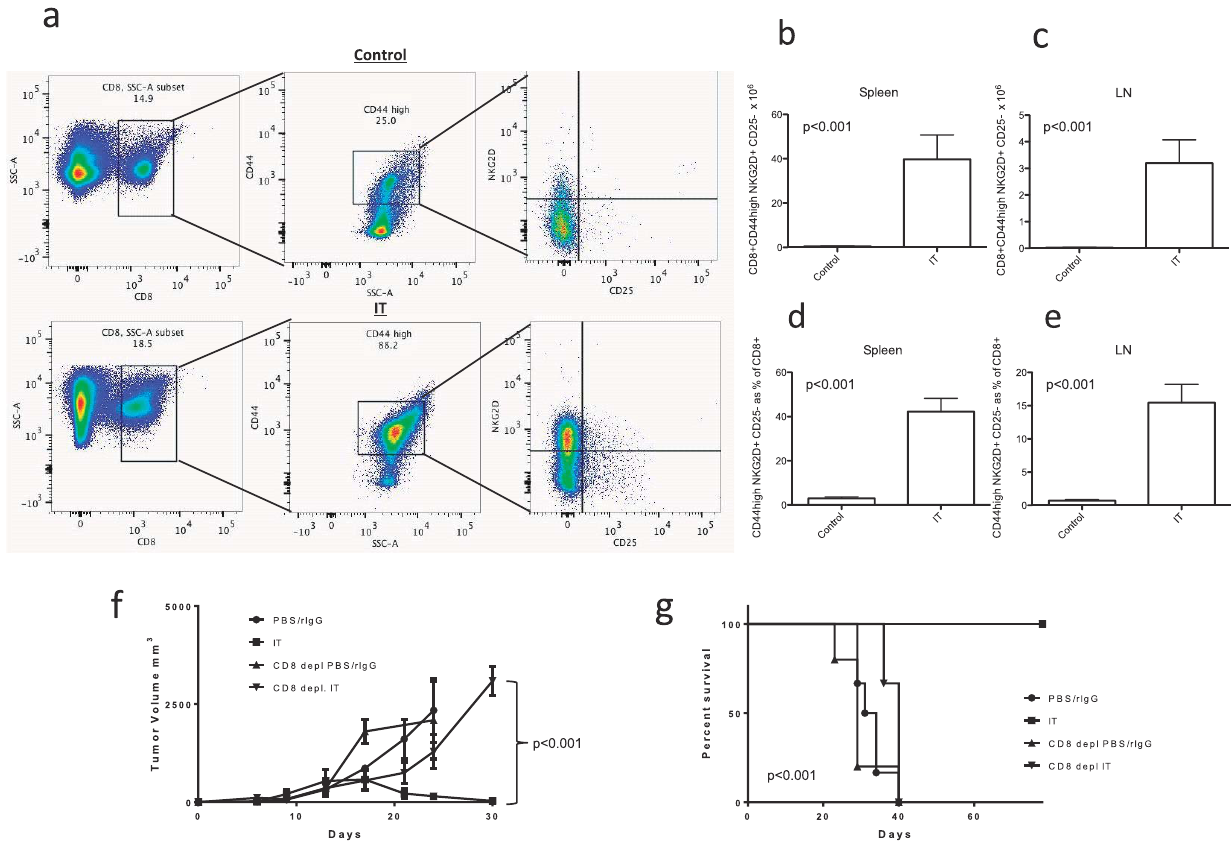
Figure 1. CD40/IL-2 Immunotherapy induces massive expansion of bystander memory CD8 + cells and anti-tumor effects are CD8 dependent. Three C57BL/6 mice per group were treated with IT or PBS/rIgG (control) and effects on CD8 + T cell expansion were quantified by flow cytometric analysis 11 days after the initiation of therapy. For in vivo tumor studies one million 3LL cells were administered by s.c. injection into the flank of C57BL/6 mice seven days prior to initiation of therapy. Six to eight 3LL bearing mice were treated with IT and/or CD8 + T cell depletion to examine CD8 + dependence of anti-tumor effects. ( a ) Gating strategy for bystander memory CD8 + CD44 high NKG2D + CD25 2 cells. ( b–e ) Expansion of bystander memory CD8 + T cells in the spleen and lymph nodes of IT or vehicle treated mice expressed as total numbers ( b,c ) or as a percentage of total CD8 + T cells ( d,e ). Effects of IT and/or CD8 depletion on tumor growth ( f ) and survival ( g ).